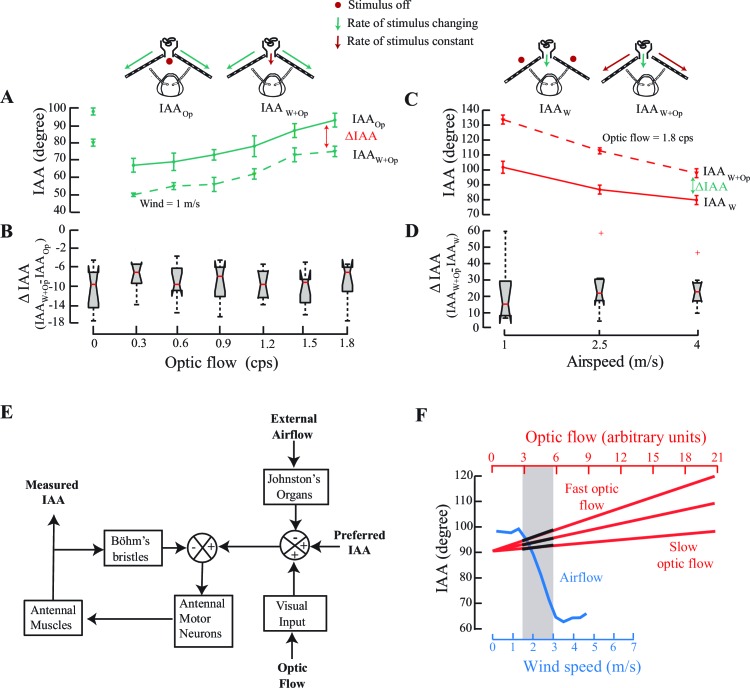
IAA responses to changes in optic flow in presence of constant airflow (A, B), and to changes in airspeed in presence of constant optic flow cues (C, D).(A) IAA responses to optic flow rates varying from 0 to 1.8 cps in presence of still air (IAAOp; solid green line vs. steady 1 m/s airflow (IAAW+Op; dotted green line). Mean difference between IAAOp and IAAW+Op is significant at each optic flow rate value (*p<0.0001, Moore’s test, N=8). (B) We have represented the mean ΔIAA values as notched plots. The range of ΔIAA (=IAAW+Op - IAAOp) is not significantly different over various optic flow values. Each mean ΔIAA is significantly different from a hypothetical mean of 0 (*p<0.05, ANOVA and post hoc Tukey’s HSD test, N=8). (C) IAA responses to varying airspeed at 1, 2.5 and 4 m/s in presence of no optic flow (IAAW; solid red line; top left panel) vs. steady optic flow of 1.8 cps (IAAW+Op; dotted red line; top right panel). Again, mean IAA values at each rate of optic flow are significantly different (*p<0.0001, Moore’s test, N=9) for the two cases. (D) The range of ΔIAA plotted as notched plots are again not significantly different across the various airspeeds, but each mean ΔIAA value is significantly different from a hypothetical mean of 0 (*p<0.05, N=9, ANOVA and post hoc Tukey’s HSD test). (E) A general model of the antennal positioning response to airspeed and optic flow cues, including the role of mechanosensory hair plates (Böhm’s bristles) in antennal positioning response. (F) The crossmodal calibration hypothesis proposes that insects simultaneously sample airflow and optic flow, and use response characteristics of airflow sensing to calibrate optic flow. Determining how the sampled optic flow varies in the dynamic range of airspeeds enables insects to linearly extrapolate the optic flow response curve over a greater range. The grey bar represents the stimulus range in which such simultaneous airflow (blue) and optic flow (black on red) measurements are made. According to this hypothesis, once a specific airflow value is correlated against the observed optic flow, which could be slow or fast, it can then be used to make measurements over much greater range of airspeeds.